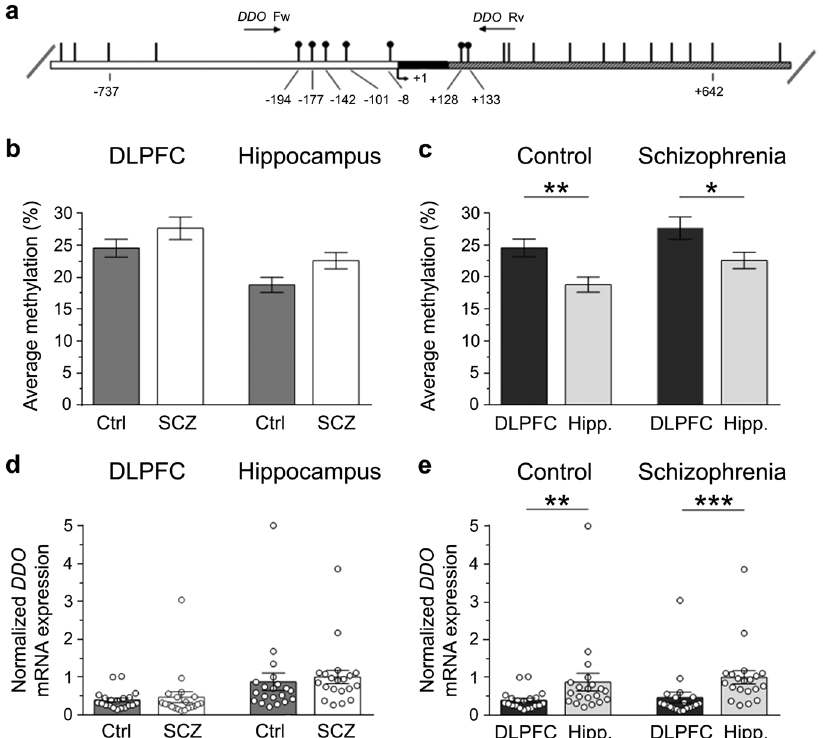
Fig. 3 DDO gene methylation and DDO mRNA expression in the dorsolateral prefrontal cortex ( DLPFC ) and hippocampus (Hipp.) of schizophrenia-affected patients ( SCZ ) and control (Ctrl) subjects. a Structure of the putative promoter of the human DDO gene. Arrow indicates the transcription start site (TSS,+1). White , black , and gray boxes represent, respectively, the putative regulatory upstream region, the exon 1 and the fi rst inton. Position of primers used for bisul fi te analysis is indicated by arrows at the top of the map ( Ddo Fw, Ddo Rv). Vertical bars represent the relative positions of each CpG site. Black circles represent the CpG sites analyzed. b , c Average methylation of the seven CpG sites analyzed is compared b between the two diagnosis groups (DLPFC: Ctrl, n = 20; SCZ, n = 20 − hippocampus: Ctrl, n = 20; SCZ, n = 19), or c between the two brain regions (Ctrl: DLPFC, n = 20; hippocampus, n = 20 − SCZ: DLPFC, n = 20; hippocampus, n = 19). The percent (%) of methylation represents the average of the seven CpG sites contained in the analyzed region. d, e DDO gene transcription is compared d between the two diagnosis groups (DLPFC: Ctrl, n = 20; SCZ, n = 20 − hippocampus: Ctrl, n = 20; SCZ, n = 20), and e between the two brain regions (Ctrl: DLPFC, n = 20; hippocampus, n = 20 − SCZ: DLPFC, n = 20; hippocampus, n = 20). The DDO mRNA expression is normalized to the mean of two housekeeping genes and expressed as arbitrary units. * p < 0.05, ** p < 0.01,*** p < 0.0001 (Mann – Whitney test). Dots represent the single subjects ’ values while bars illustrate the means ±